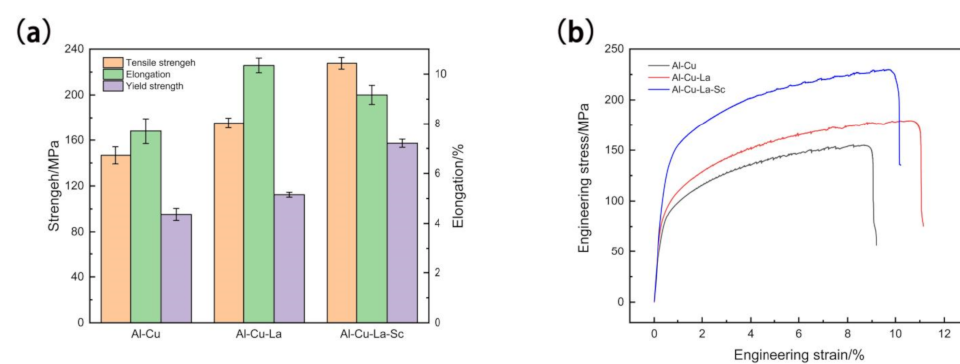
Figure 4. The mechanical properties ( a ) and engineering stress-strain curves ( b ) of Al-Cu, Al-Cu-La, Al-Cu-La-Sc alloys.